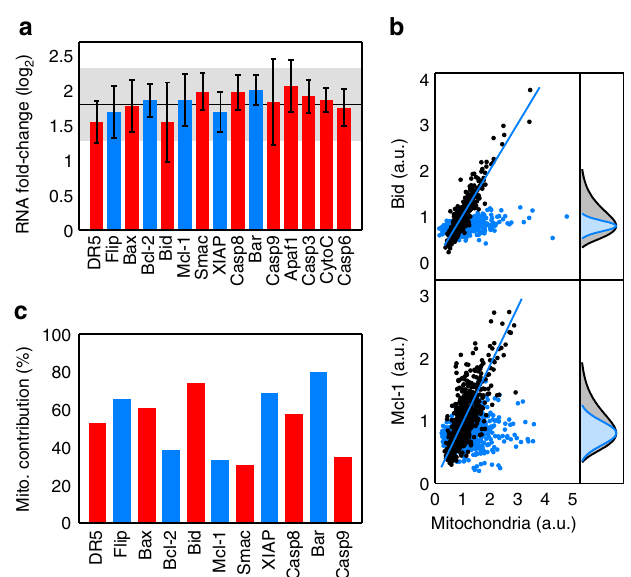
Fig. 3 In fl uence of mitochondrial content on apoptotic mRNAs and protein abundances. a Logarithmic fold-change in mRNA expression of apoptotic genes between subpopulations of cells with low and high mitochondrial content. HeLa cells labelled with MG were sorted in two populations according to their mitochondrial content, and RNA extracted and sequenced (three independent sorting experiments were performed). The solid line corresponds to the average fold-change of the whole genome (~10,000 genes). The shaded region is the fold-change standard deviation across the whole genome. Red bars denote pro-apoptotic mRNAs and blue bars, anti-apoptotic. Error bars are standard deviations of three biological replicates for each gene. b Scatter plots of mitochondrial mass and protein levels in single HeLa cells (black dots). Here, we show a pro-apoptotic protein (Bid, upper panel) with a high correlation with the mitochondrial content and an anti-apoptotic protein (Mcl-1, lower panel) with smaller correlation. Blue lines represent regression lines. The corresponding distributions of protein levels are shown in grey in the right panels. The co- variation with mitochondrial content is removed (blue dots) to estimate the fraction of protein variance not due to mitochondrial levels (blue distributions). c Mitochondrial contribution to global variability in protein levels from different apoptotic genes, as de fi ned in the main text. Pairs of antagonistic pro-apoptotic (red) and anti-apoptotic (blue) proteins are shown next to each other. Ensembles of 200 – 300 cells for each protein antibody were used to estimate the mitochondrial contribution to